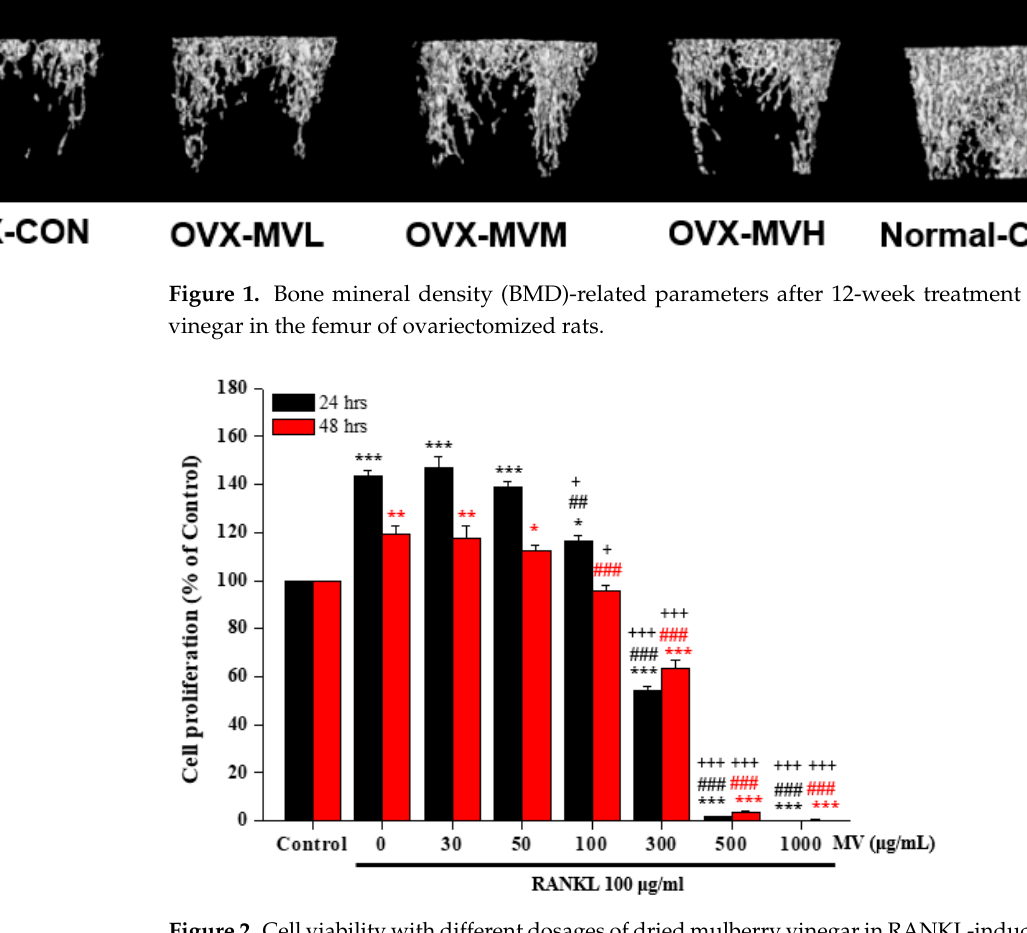
Figure 2. Cell viability with different dosages of dried mulberry vinegar in RANKL-induced Raw264.7 cells. Bars and error bars represented mean ± standard deviation ( n = 5). * Significantly different